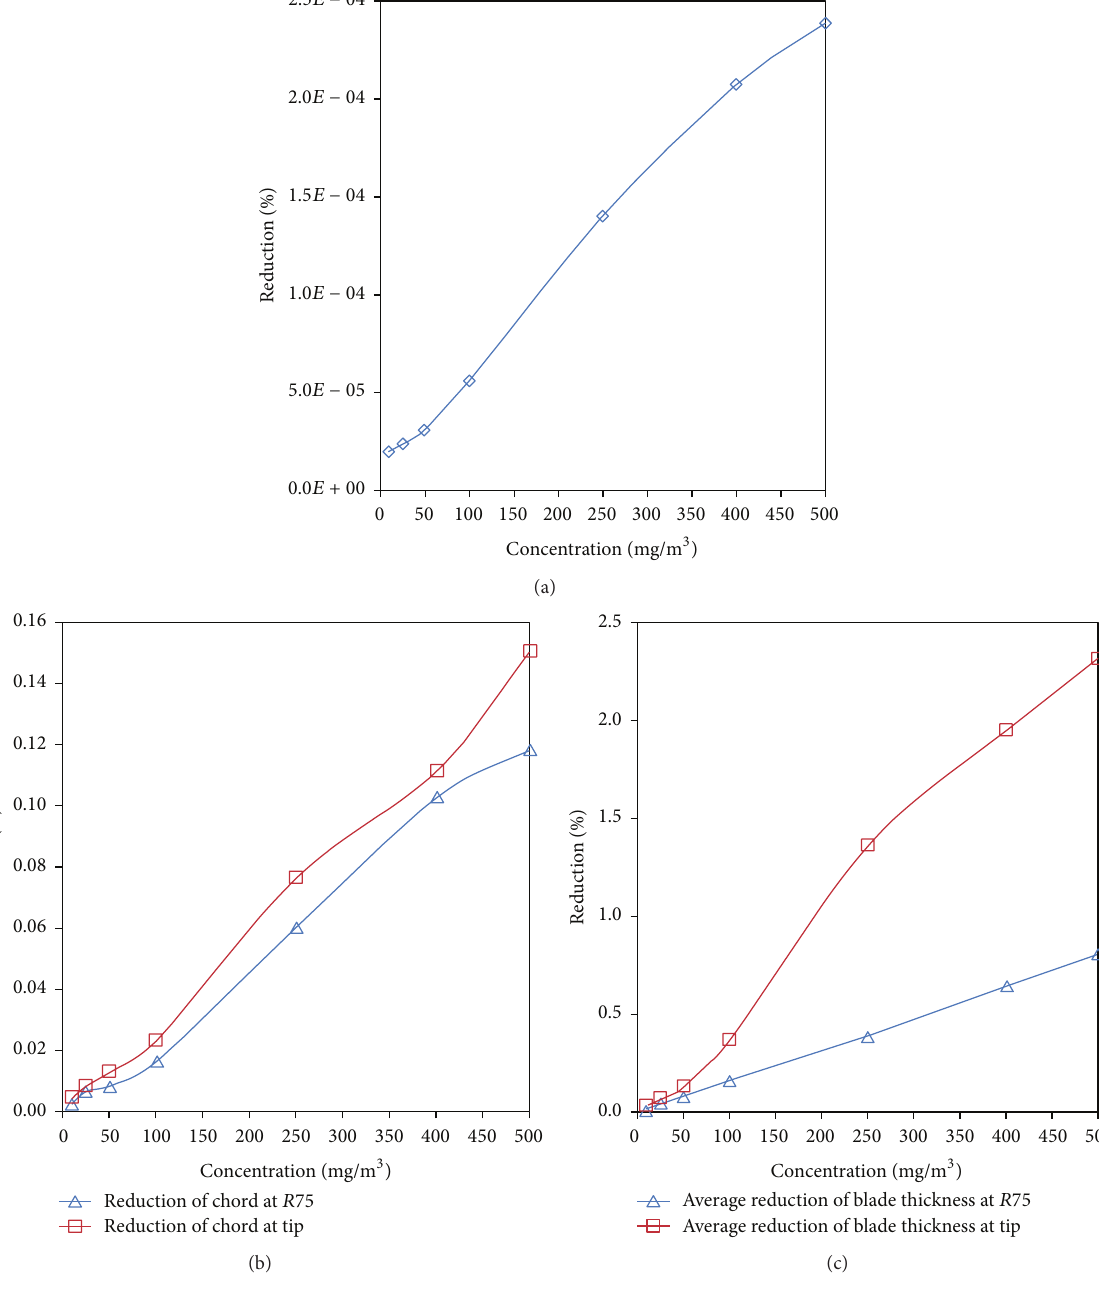
Figure 15: Blade geometry deteriorations with concentration after one hour of sand ingestion: (a) reduction of length, (b) reduction of chord, and (c) reduction of